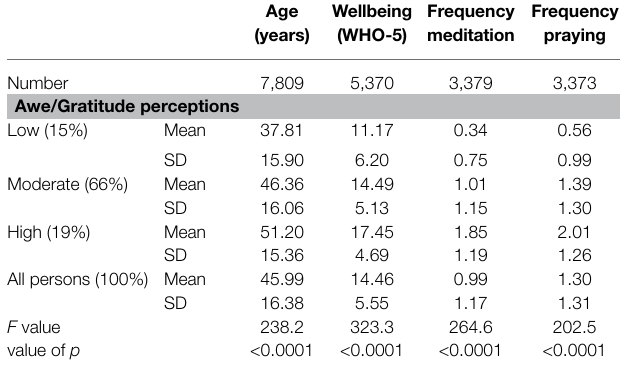
TABLE 3 | GrAw-7 categories and relation to age, wellbeing, and spiritual